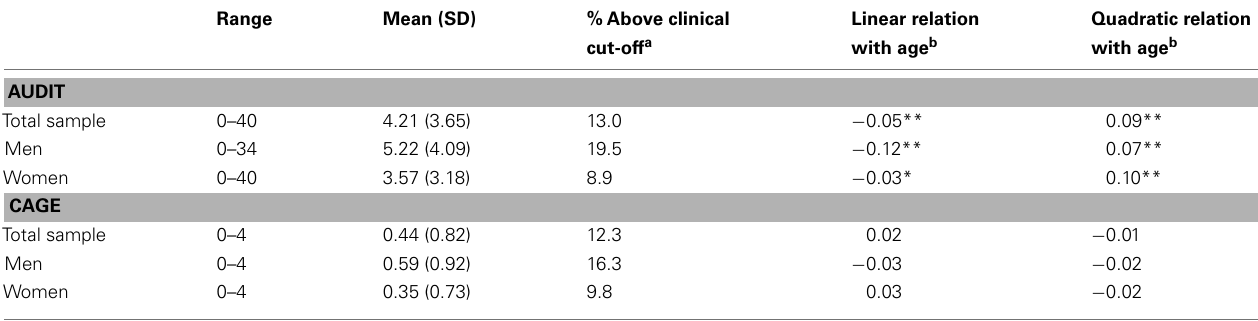
Table 1 | Distributions ofAUDIT and CAGE and their associations with sex and